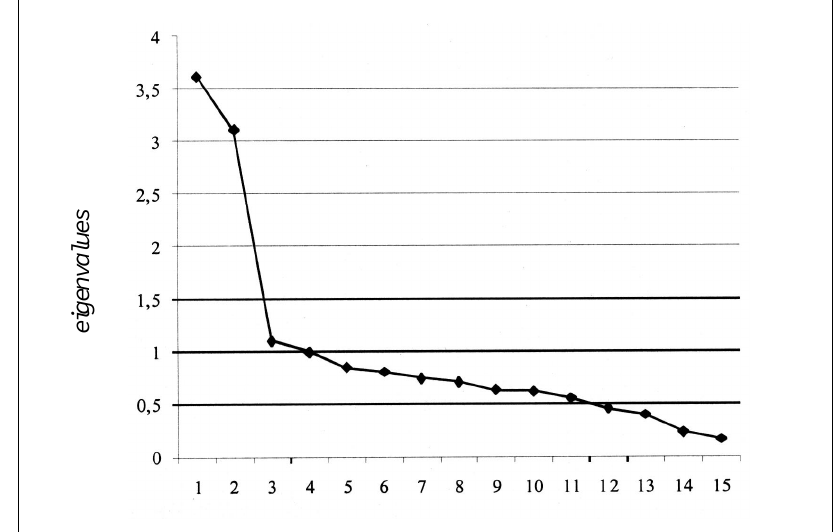
Número de componentes Figura 1 . Teste do scree plot